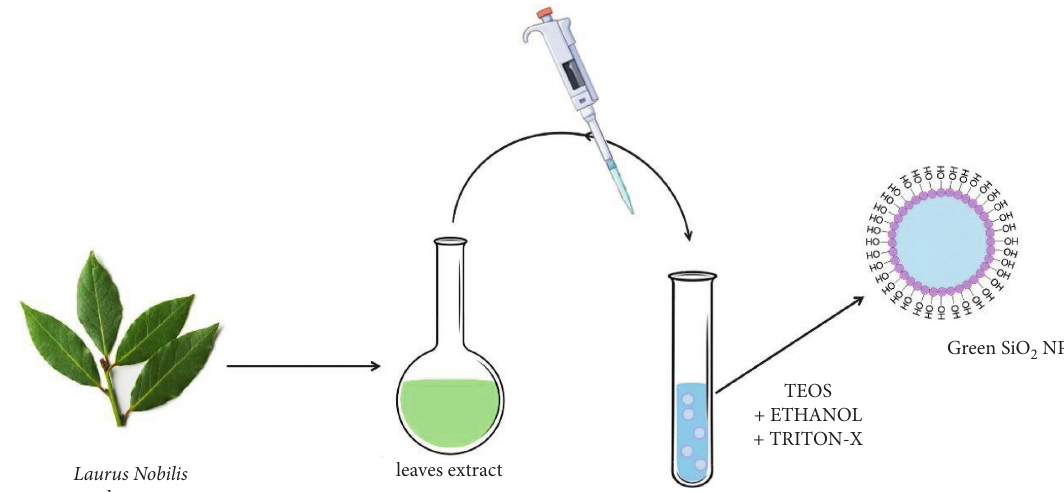
Figure 3: Schematic representation of SiO